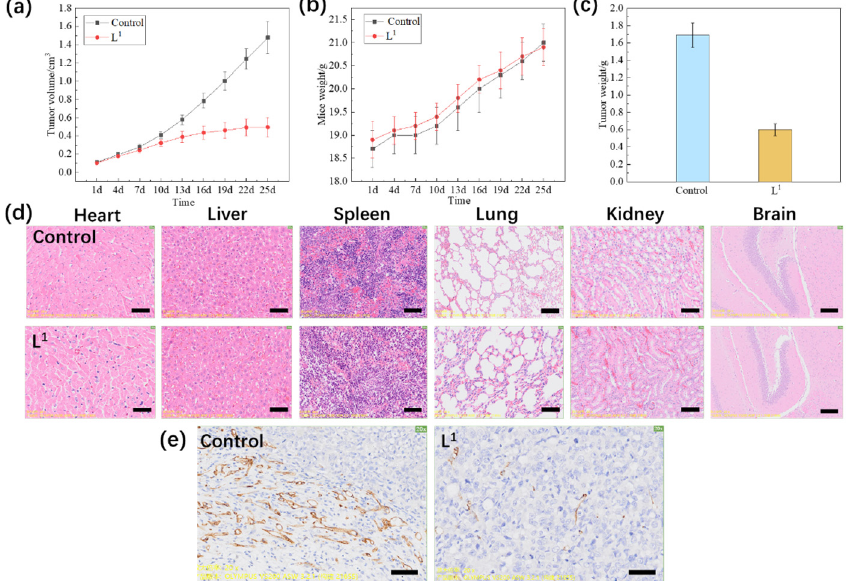
Figure 6. ( a ) Change in tumor volume of mice injected with L 1 (10 mg/kg) compared with PBS control; ( b ) change in body weight of mice injected with L 1 (10 mg/kg) compared with PBS control; ( c ) the tumor weight of mice injected with L 1 (10 mg/kg) compared with PBS control after 25 days; ( d ) haematoxylin and eosin staining of the brain, heart, liver, spleen, lung, and kidney tissues collected from mice on the 25th day after intravenous injection of L 1 (10 mg/kg), compared to that from mice on the 25th day after intravenous injection of PBS as a control; ( e ) CD31 immunohistochemical staining of tumor model mice on the 25th day after an intravenous injection of L 1 (10 mg/kg) and PBS control. Scale bar = 20 μ m. Error bars are based on standard errors of the mean (n = 3).